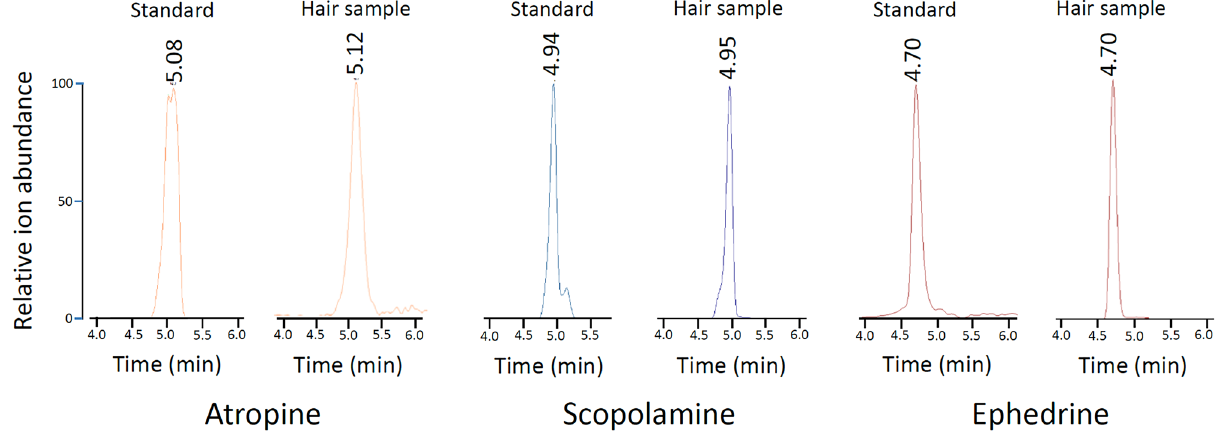
Figure 5. UHPLC-HRMS results from the analyses of alkaloid standards at 1000 pg/µL and of one of the three replicated hair samples from the cave of Es Càrritx (10.1 mg). Alkaloids were monitored at m/z = 290.175 (atropine), m/z = 304.155 (scopolamine) and m/z = 166.123